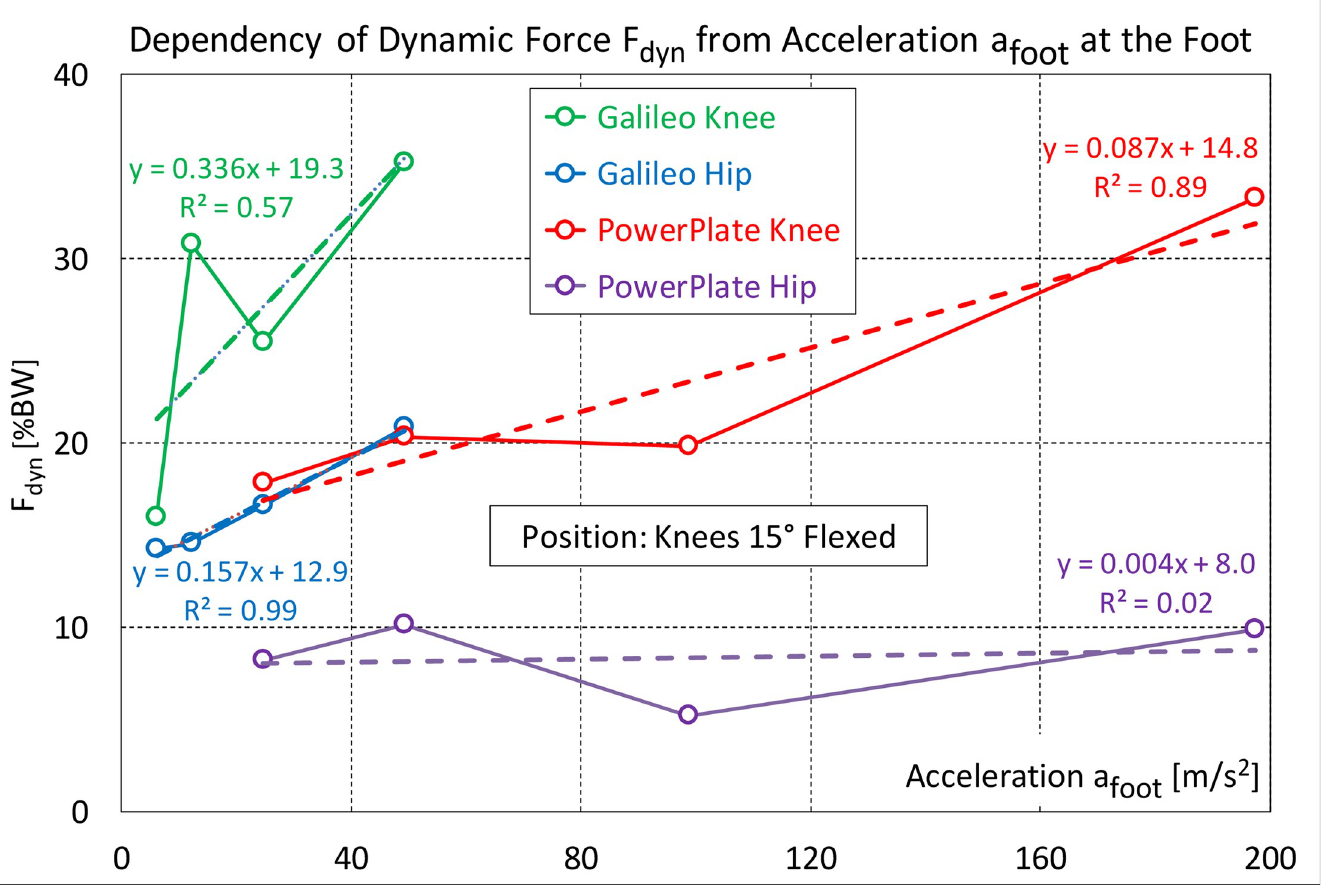
Fig 6. Relation between dynamic force and peak acceleration at the foot. Only for the Galileo data from the hip and the Powerplate data from the knee was a good linear correlation found between the dynamic force F dyn and the acceleration a foot at the foot. Because none of the correlation lines cross the zero point, F dyn doesn’t change proportionally to a foot